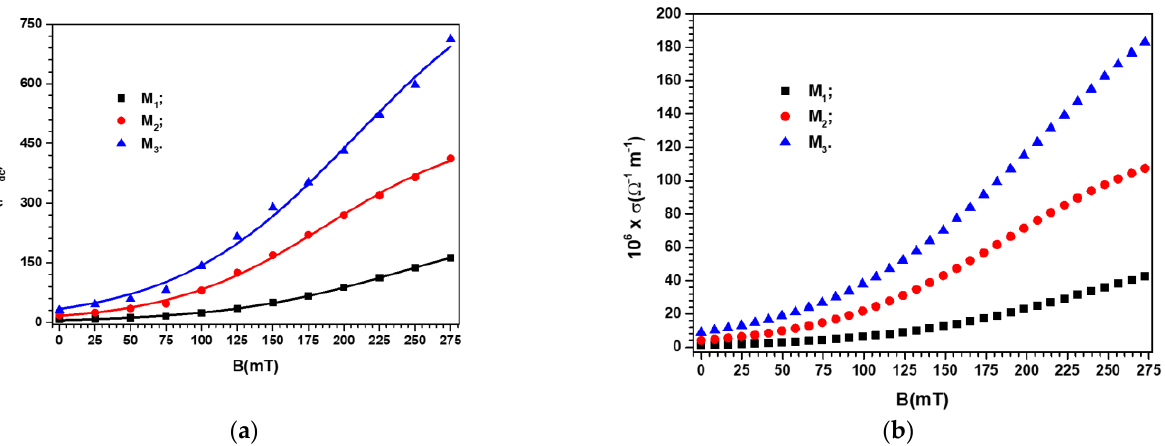
Figure 8. ( a ) The intensity, I , of the electric current through the devices ED 𝑖 (𝑖 = 1,2,3) , depending on the B values of the magnetic flux density (points — experimental data, lines — polynomial fits); ( b ) on the B values of the magnetic flux density (points—experimental data, lines—polynomial fits); The electrical conductivity σ of the membranes M 𝑖 (𝑖 = 1,2,3) depending on the B values of the ( b ) The electrical conductivity σ of the membranes M i ( i = 1,2,3 ) depending on the B values of the magnetic flux density. magnetic flux